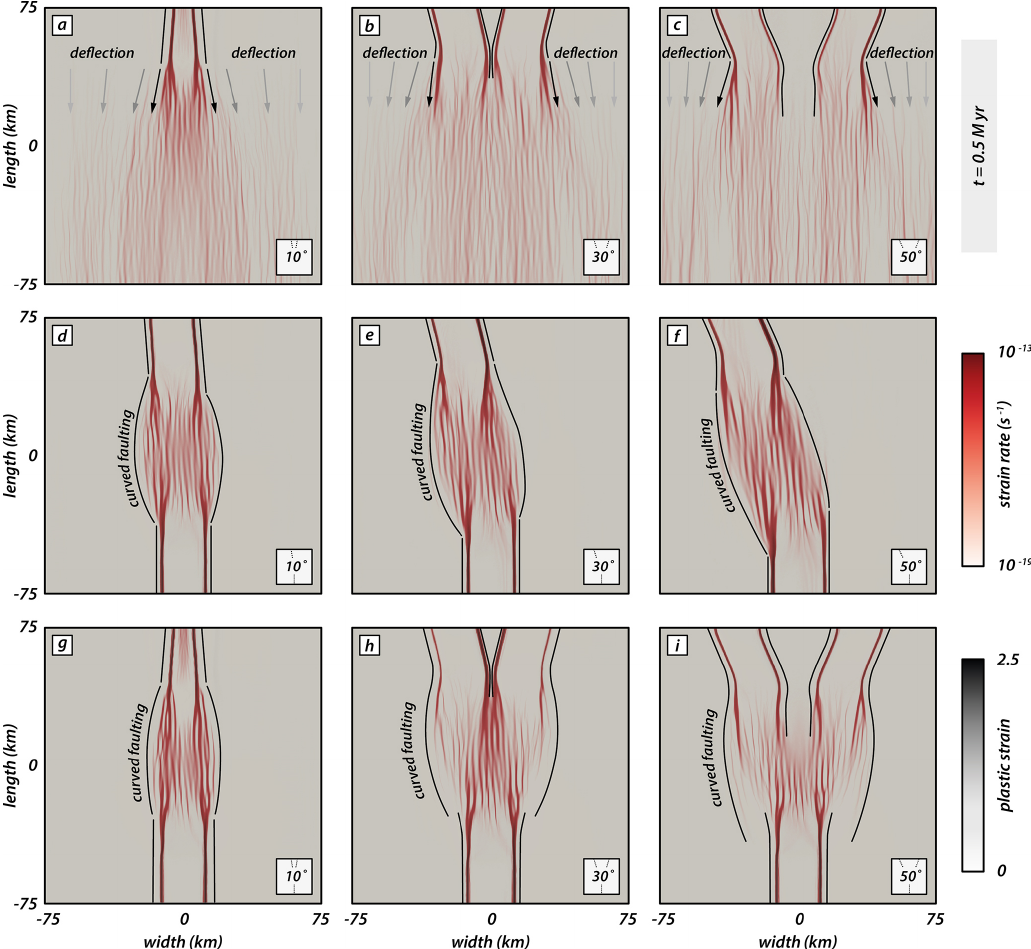
Figure 6. Types of rift segment linkages depending on the seed configuration at an early phase after 0.5 million years. Model top views show strain rates (logarithmic) and plastic strain in red and black, respectively. (a–c) The v -seed configuration for intermediate angles of 10, 30, and 50 ◦ . (d–f) The i -seed configuration for intermediate angles of 10, 30, and 50 ◦ . (g–i) The y -seed configuration for intermediate angles of 10, 30, and 50 ◦ (reference model). Black lines confine deformed areas. For models with a v -seed configuration (a–c) , competing rift segments deflect away from each other, resulting in a fan-shaped geometry. Note that fault strike successively re-orients into an orientation perpendicular to the extension direction towards the left and right model sides. Curved faulting occurs in models with an i - and y -seed configuration (d–j) wherein rift segments